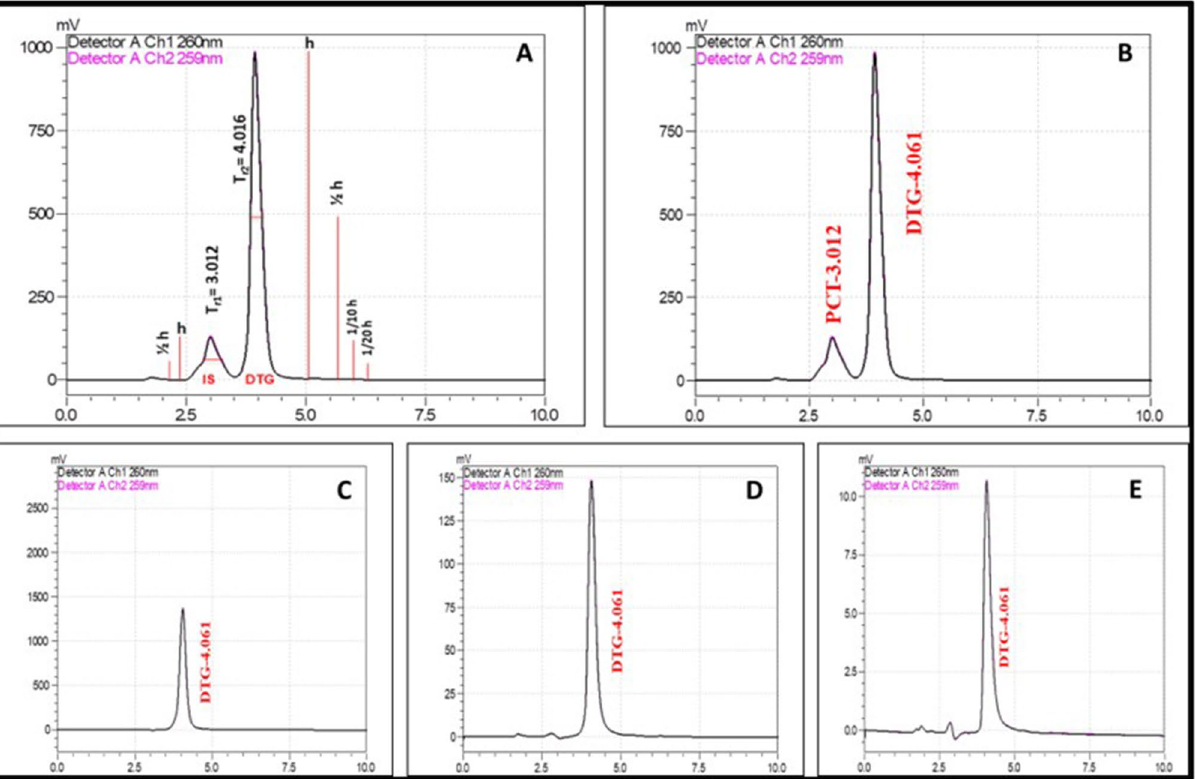
Figure 1. The comparative HPLC chromatograms of Dolutegravir developed using a mixture of water, acetonitrile and methanol in the ratio of 20:40:40 with 0.2% formic acid as the mobile phase. ( A ) System